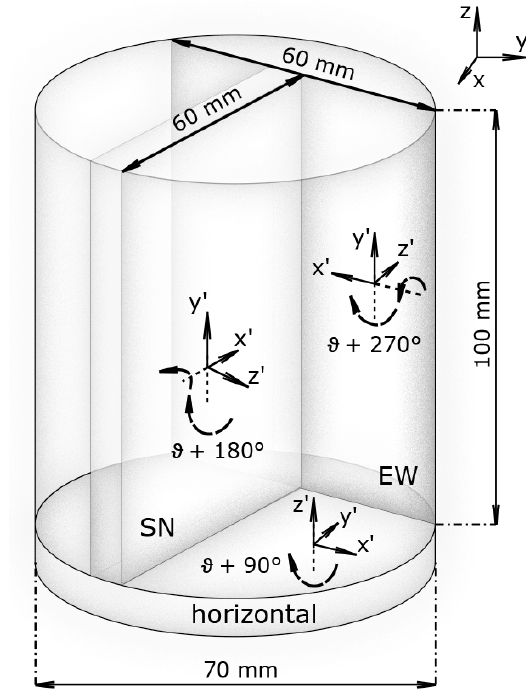
Figure 4. Cutting scheme for the ice core analysis. An 11cm long piece of the ice core was cut in a horizontal ( d = 7cm) and two vertical (east–west- and south–north-oriented, 10 × 6cm) thin sec- tions. Four thin sections of each type were analysed and combined per sampling